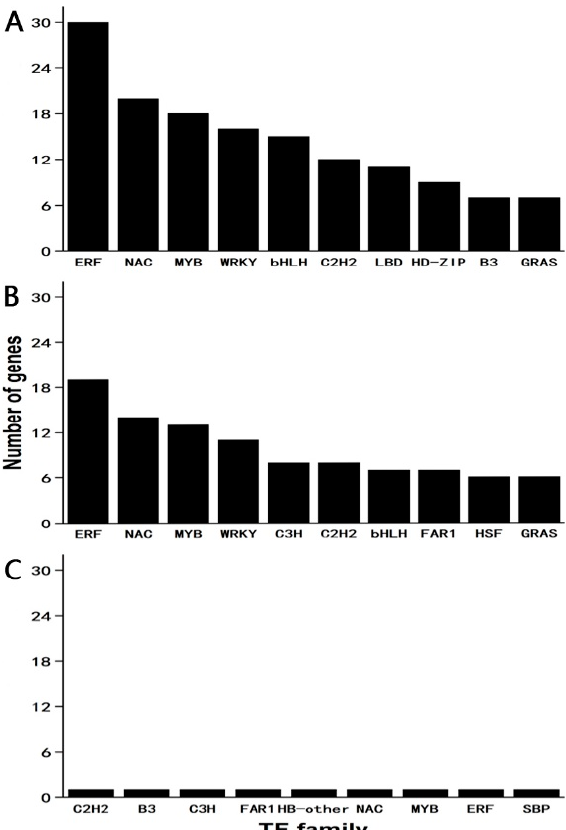
Figure 5. The number distribution of DEGs (FDR < 0.05 and absolute log 2 fold change ≥ 1) that belong to the top 10 transcription factor families identified from three comparisons. ( A ) DS0 vs. DT0; ( B ) DS0 vs. DS6; ( C ) DT0 vs. DT6. DS0 signifies desiccation-sensitive seeds dried for 0 d; DS6: desiccation-sensitive seeds dehydrated for 6 d; DT0, desiccation-tolerant seeds dried for 0 d; DT6, desiccation-tolerant seeds dehydrated for 6 d.